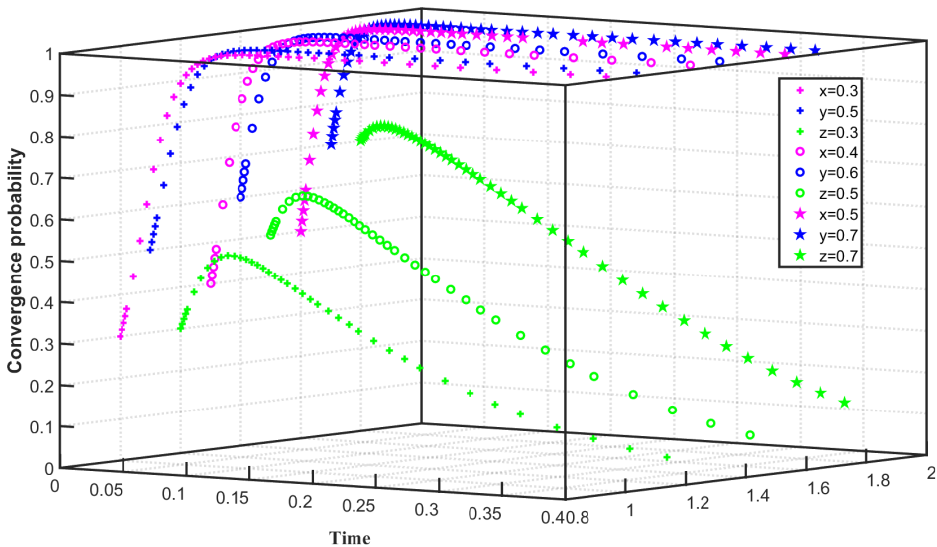
Figure 5. Evolution path of tripartite game system under low emission reduction cost and high government subsidy.